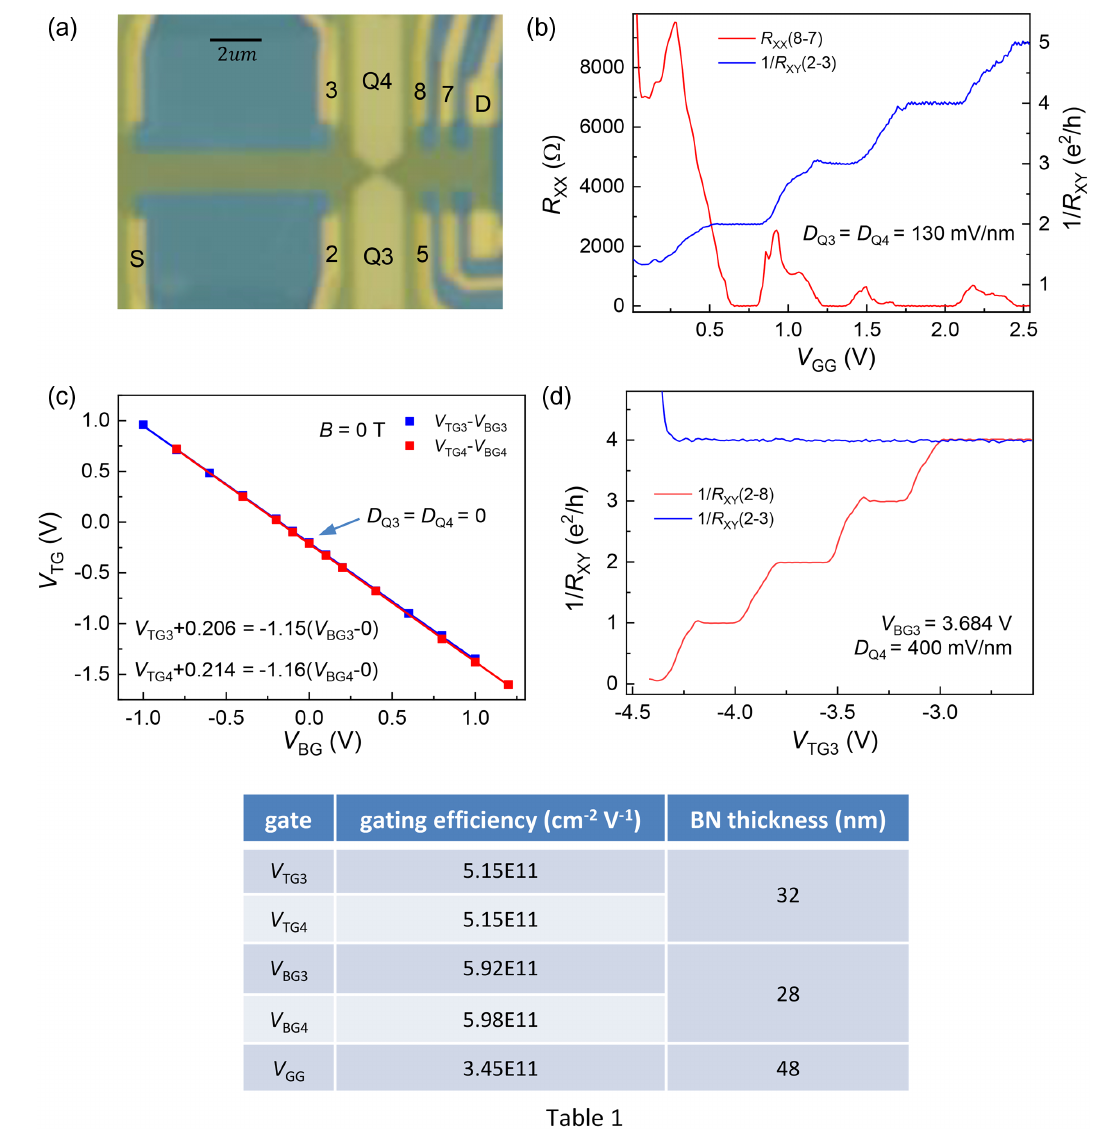
FIG. 7. (a) An optical image of device 606. (b) Bulk R well-developed IQHE in the bulk of the bilayer graphene. (c) V corresponding to D LP insulating phase of ν ¼ 0 with D Table 1 summarizes the gating efficiencies of all five gates and the thickness of the h -BN flakes